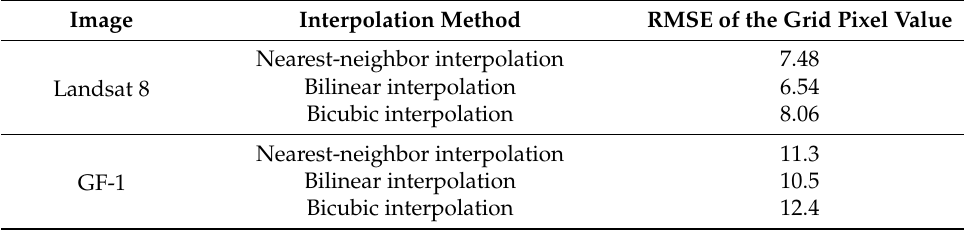
Table 7. RMSE of hexagon-gridded images from different data resources.